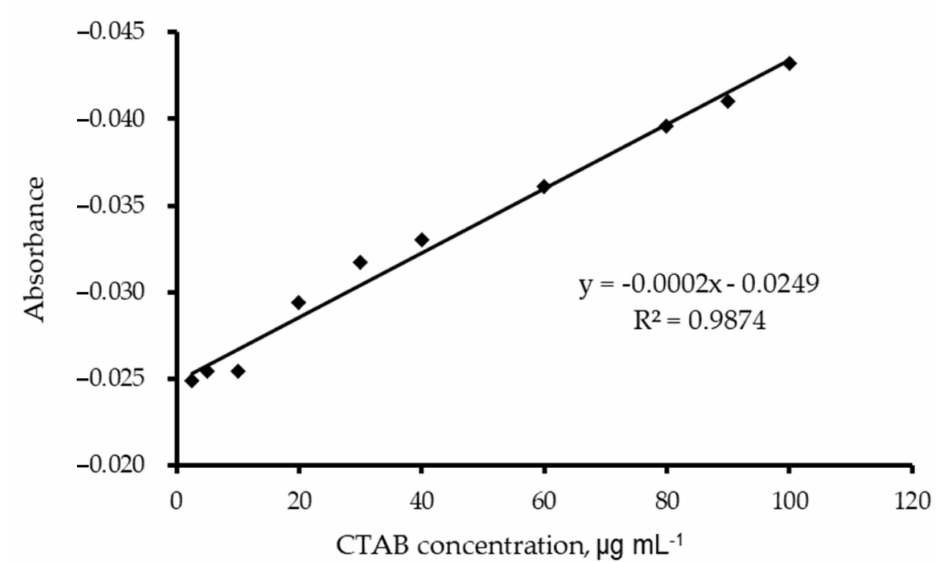
Figure 10. Analytical curve for the flow injection determination of CTAB concentration using Cu-PCV as carrier solution (1.0 mmol L − 1 each), sample loop 200 µ L, carrier flow rate 3.5 mL min − 1 , and measurement at 430